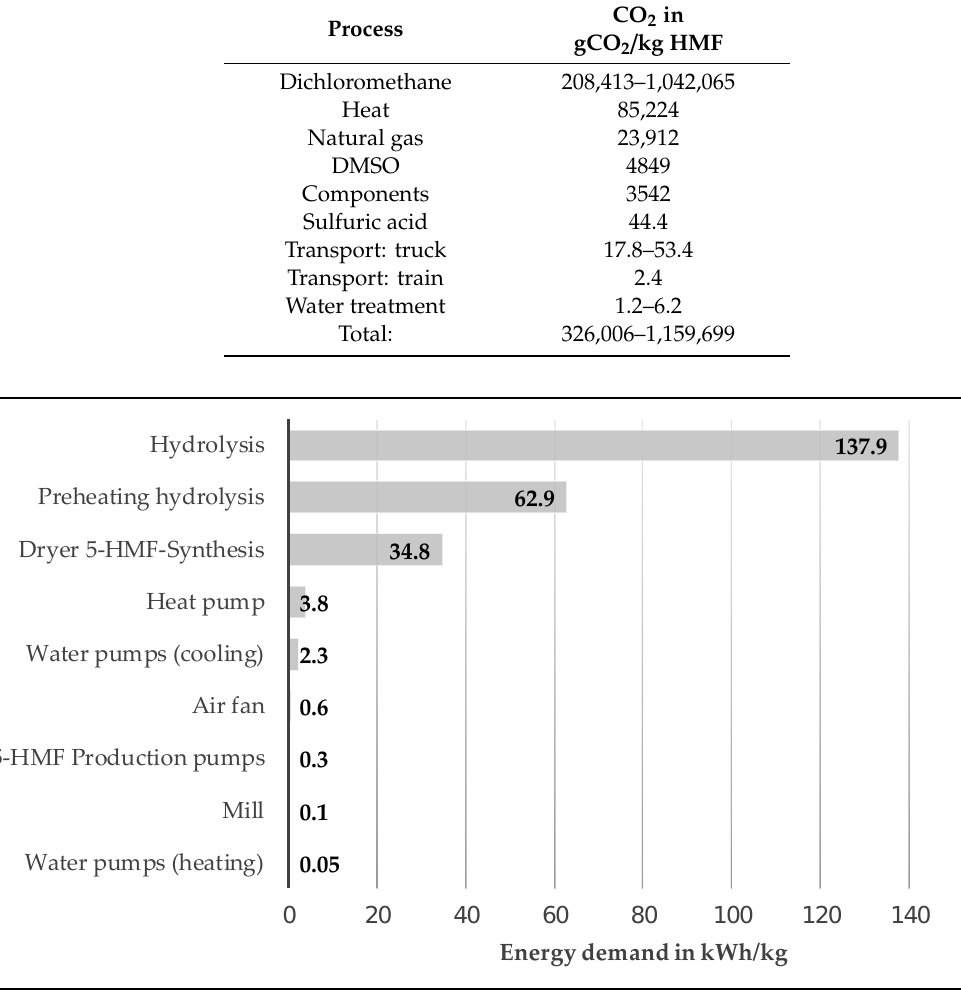
Figure 3. Energy consumption in the synthesis of HMF (according to the pilot process of the literature [15]).